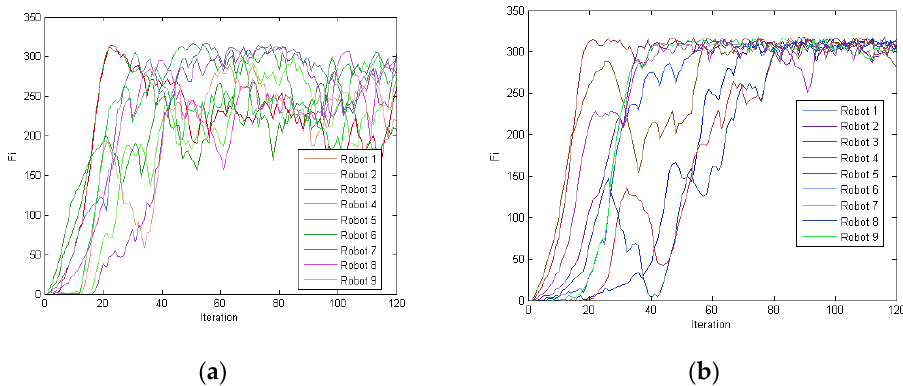
Figure 11. The F i evolution of each robot for coverage in noise free environment: ( a ) The controller in Reference [27]; ( b ) A1.